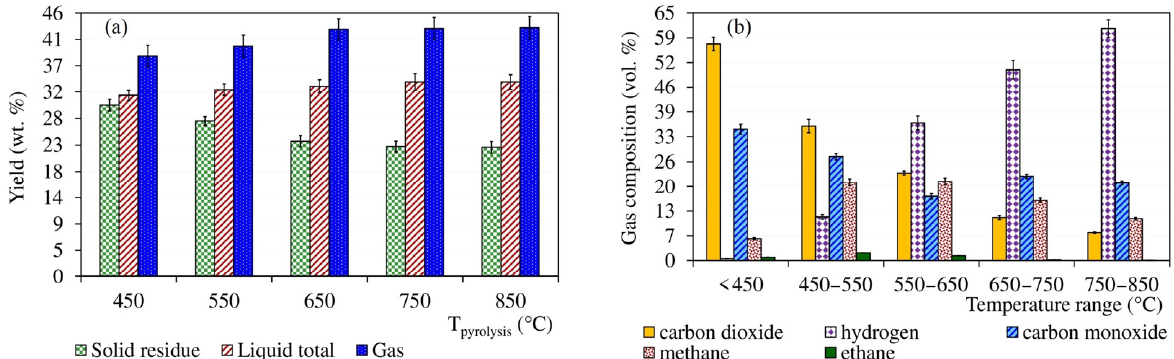
Figure 2. The yields of condensates, solid residues, and gases ( a ) complemented by the temperature dependence of the gas composition ( b ).